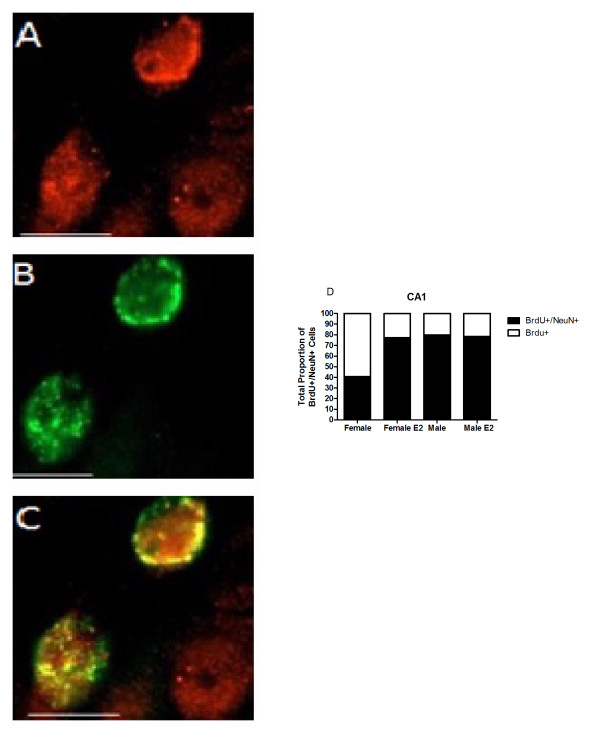
Confocal images of neurons in CA1 pyramidal layer cell layer of the hippocampus at 100× magnification. 5-bromo-2-deoxyuridine (BrdU) immunofluorescence was combined with immunostaining for the neuronal marker, NeuN, at 3 weeks (PN21). (A) Confocal image showing NeuN+ cells. (B) Confocal image showing BrdU+ cells. (C) Merged image of both BrdU+/NeuN+ cells. (D) Graph representing total proportion of BrdU+/NeuN+ cells in CA1. Scale bars = 10 μm.